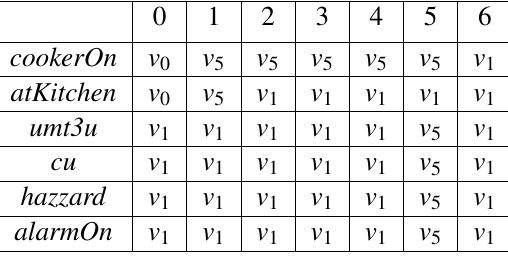
Table 2. Scenario 2 by Forward